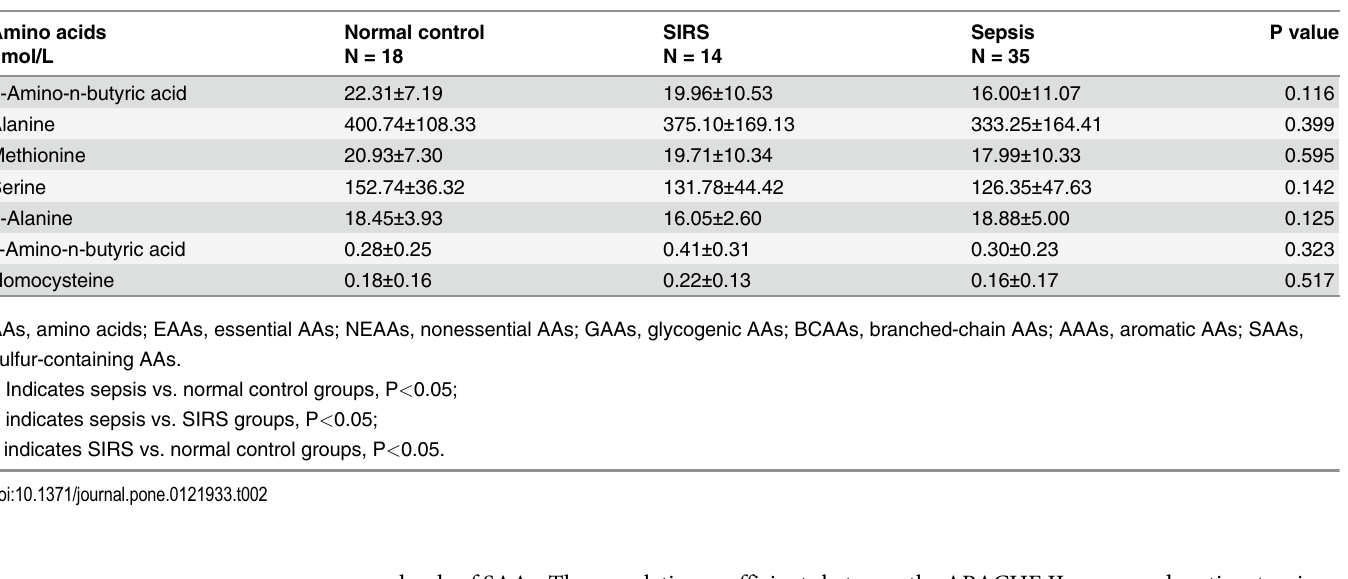
former three parameters.